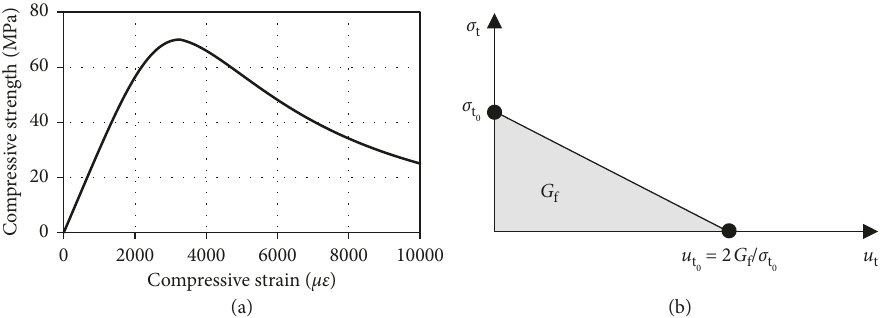
Figure 15: Material model of SFRC. (a) Compression (Lee et al. [43]). (b) Postfailure stress-fracture energy curve.